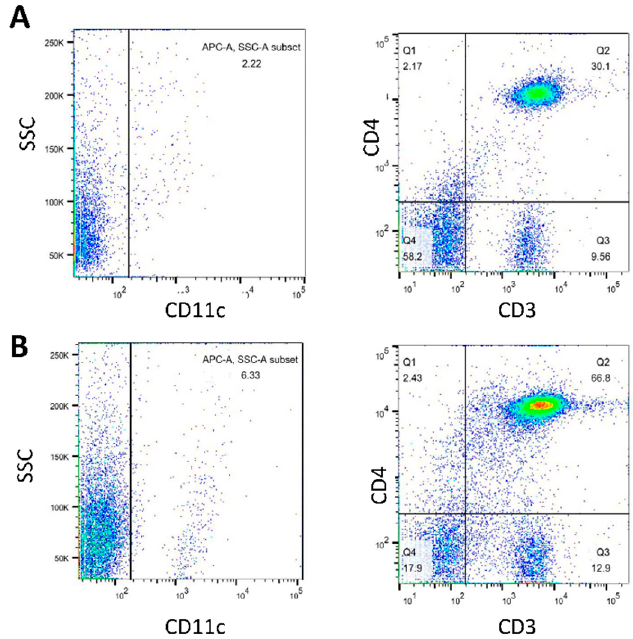
Figure 6. Cell populations inside the bone marrow dendritic cell decellularized lymph node scaffolds (BMDC-dLN) after in vivo immunization. After in vivo immunization, BMDC-dLNs were examined for the populations of CD3+ T lymphocytes, CD4+ T helper lymphocytes, and CD11c+ dendritic cells (DCs). ( A ) Native mouse lymph node and ( B ) BMDC-dLN.